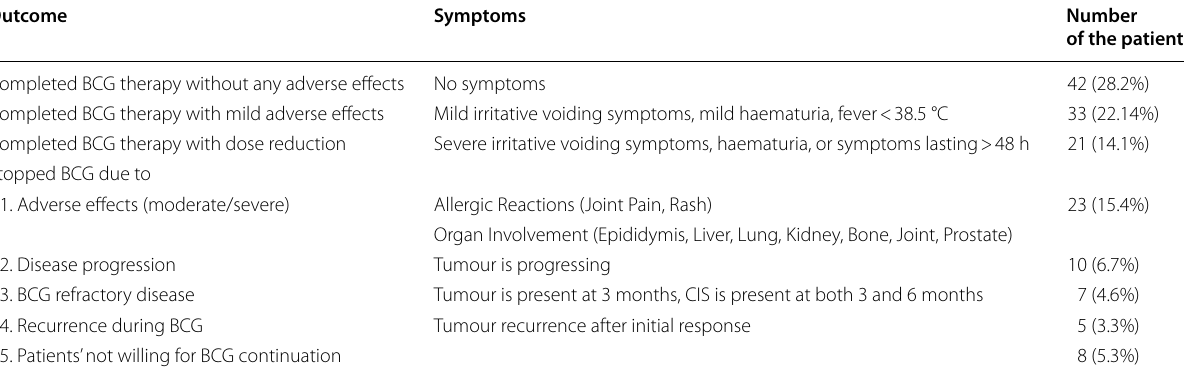
of the patients